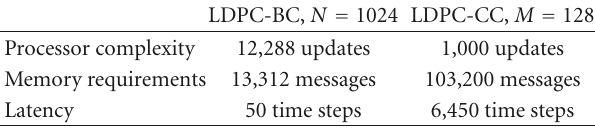
Table 1: Complexity comparisons for (3,6) rate-1 / 2 LDPC block and convolutional codes corresponding to Figure